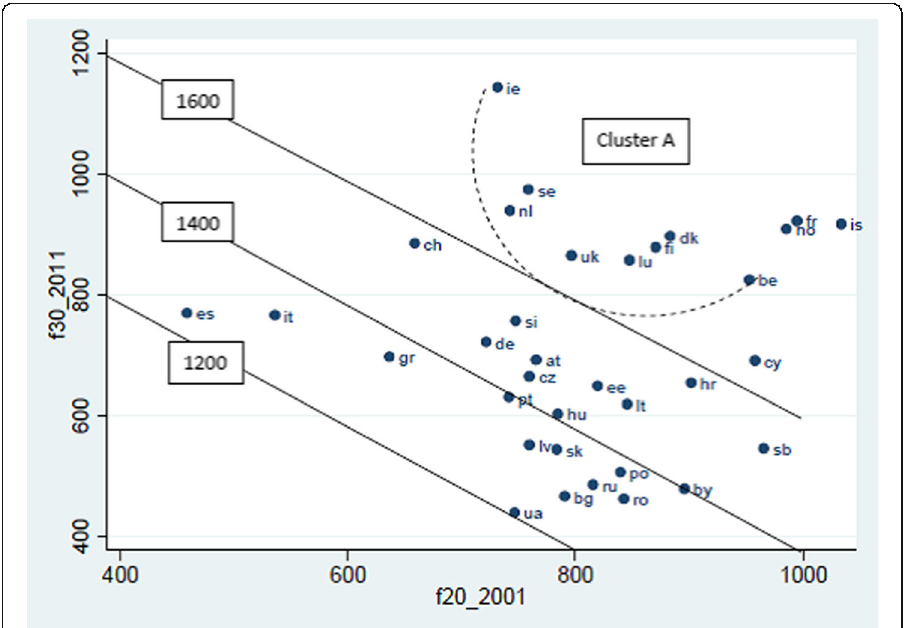
Fig. 4 Plot of cumulated fertility in the age group 30 – 40 (f30) (recuperation phase) in 2011 against cumulated fertility in the age group 20 – 29 (f20) (postponement phase) 10 years earlier, European